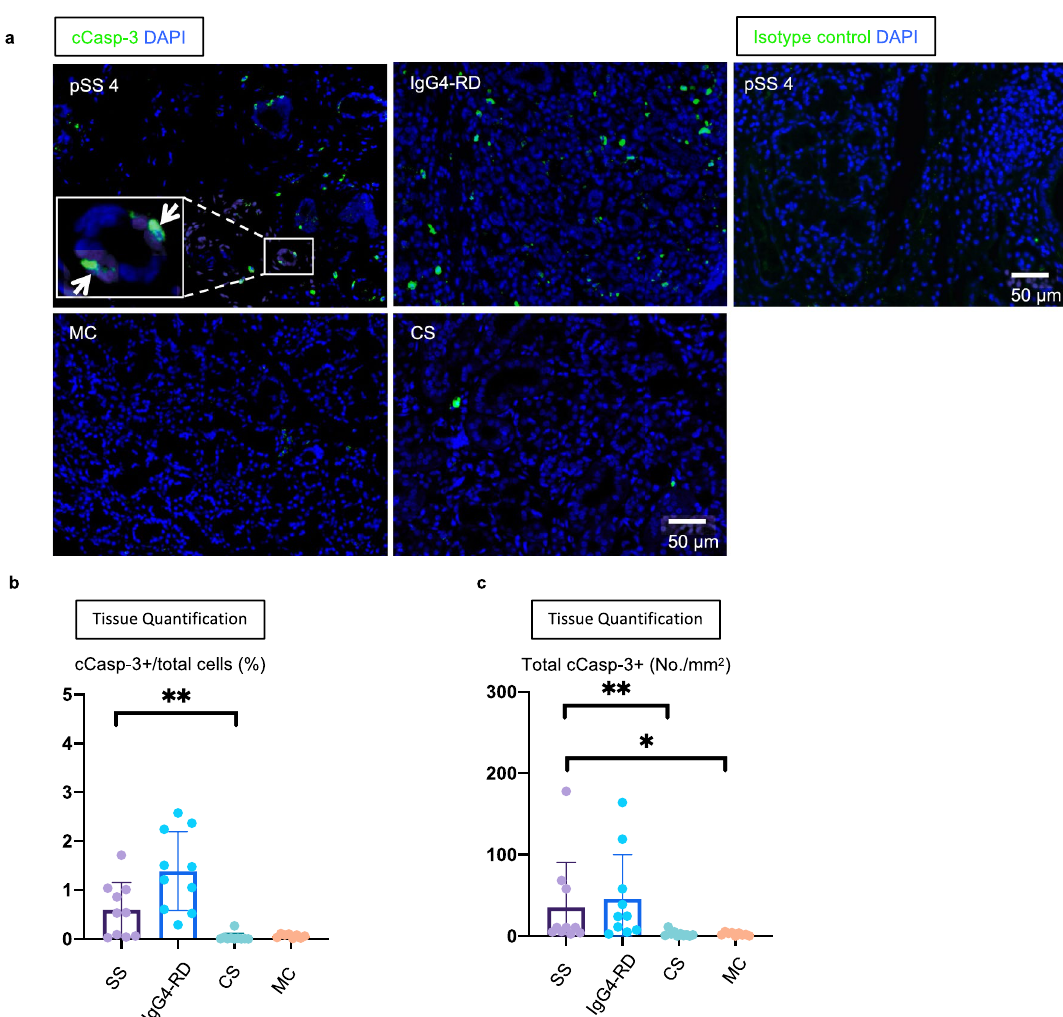
Figure 3. Apoptotic cells accumulate in tissues from SS and IgG4-RD patients. ( a ) Representative multi-color immunofluorescence images showing cleaved caspase-3 (cCasp-3) (green) and DAPI (blue) staining in pSS, IgG4-related disease (IgG4-RD), mucous cyst (MC) and chronic sialadenitis (CS). White arrows indicate cCasp-3 positive apoptotic cells. Right panel sowing isotype control (green) staining in pSS. ( b and c ) Absolute numbers ( b ) and proportions ( c ) of cCasp-3 positive apoptotic cells in pSS (n = 10), IgG4-RD (n = 10), MS (n = 8) and CS (n = 10). Multiple comparisons are controlled for by Dunn’s test. Error bars represent mean ± SEM. **p < 0.01; ***p <